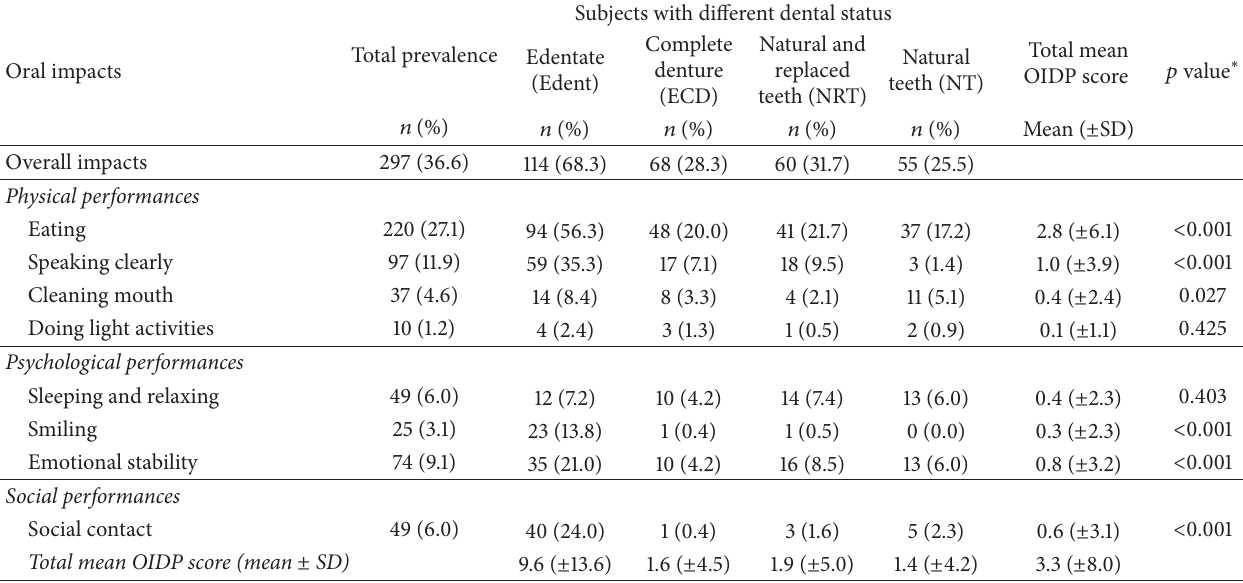
Table 1: Comparisons of prevalence and total mean OIDP score of oral impacts on daily performances between the